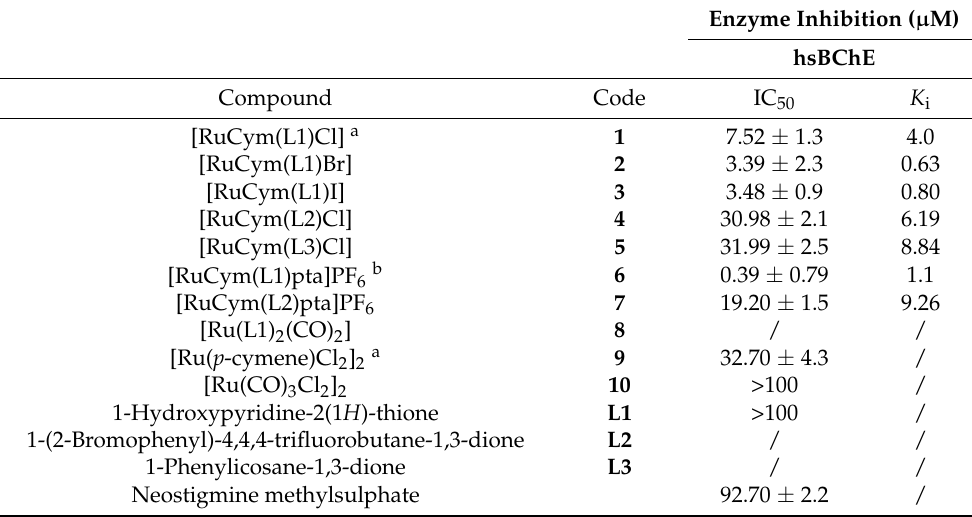
Table 2. Inhibition of horse serum butyrylcholinestarse (hsBChE) by the ruthenium compounds 1 – 10 and the free ligands L1 – L3